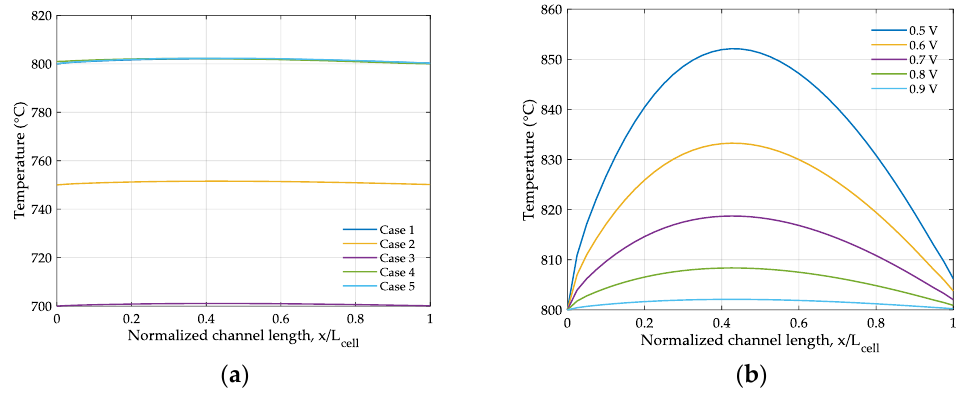
Figure 7. Temperature profile along the fuel channel: ( a ) at an operating voltage of 0.9 V and ( b ) with different operating voltages from 0.5 to 0.9 V for case 1 having an electrolyte thickness of 100 μm and an operating temperature of 800 °C.